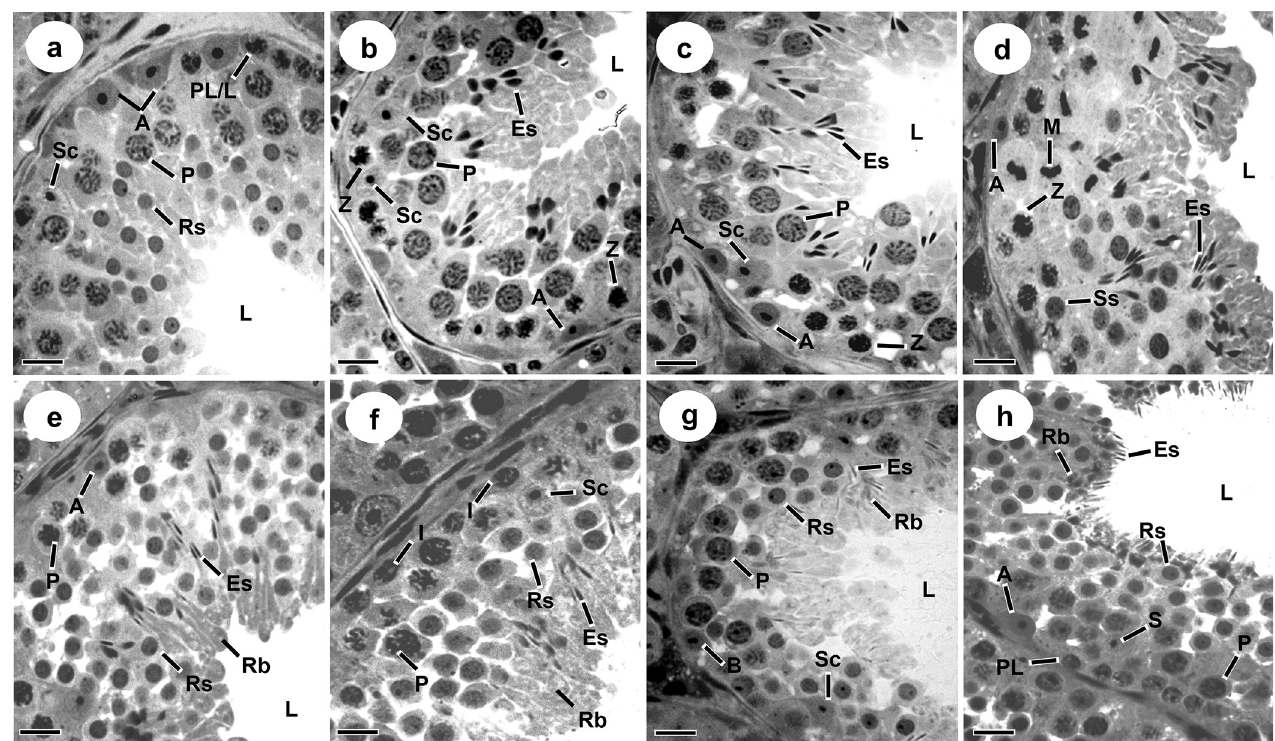
Fig 2. Stages of the seminiferous epithelium cycle (SEC) of Diphylla ecaudata according to the Tubular Morphology Method. a: Stage I; b: Stage II; c: Stage III; d: Stage IV; e: Stage V; f: Stage VI; g: Stage VII; h: Stage VIII. Sc: Sertoli cell nuclei; A: Type A spermatogonia; I: Intermediate spermatogonia; B: Type B spermatogonia; PL/L: Preleptotene/Leptotene primary spermatocyte; Z: Zygotene primary spermatocyte; P: Pachytene primary spermatocyte; M: Meiotic division; Ss: Secondary spermatocyte; Rs: Round spermatid; Es: Elongated spermatid; Rb: Residual body; L: Lumen. Scale bar: 20 μ m.